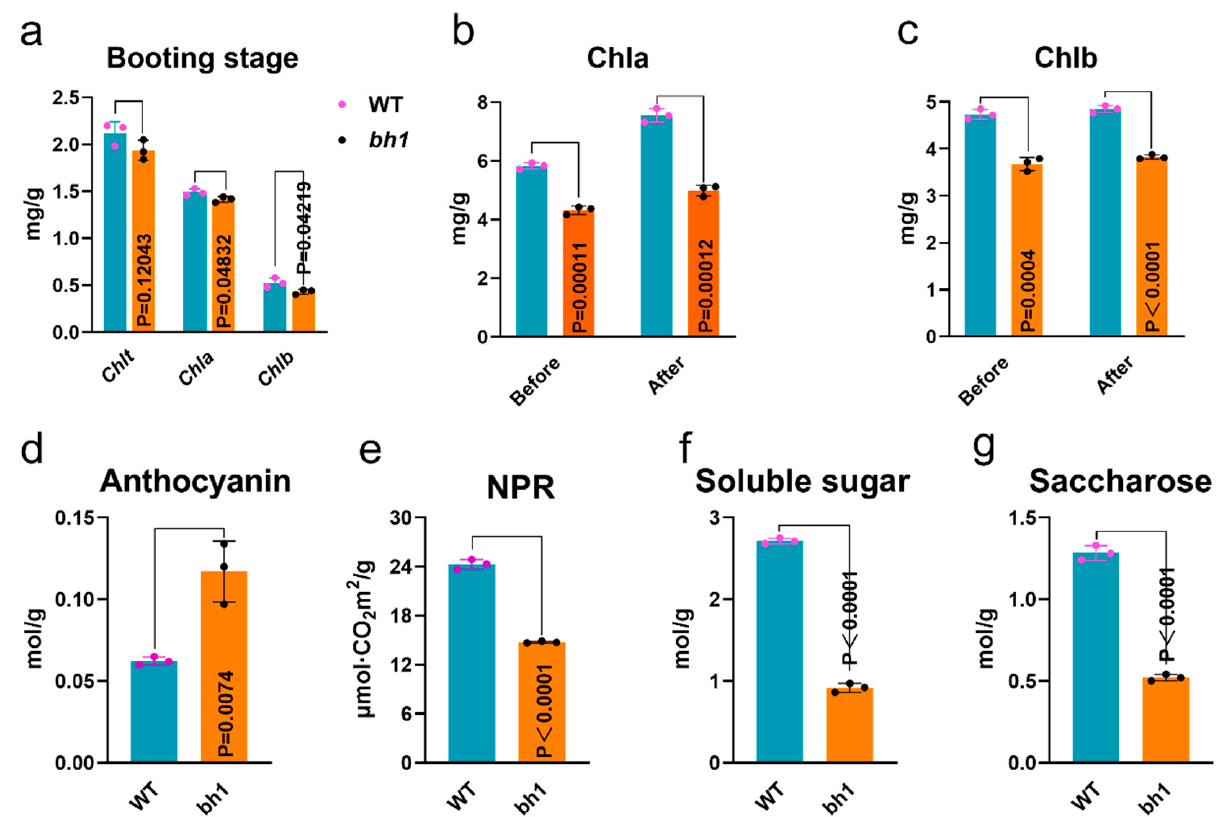
Figure 2. Comparison of photosynthetic parameters, anthocyanins and sugars contents of WT (wild type) and brown hull 1 (bh1). ( a ) Determination of photosynthetic pigment at booting stage ( b ) chlorophyll a, ( c ) chlorophyll b, ( d ) anthocyanin content in the hull, ( e ) net photosynthetic rate of mature leaves, ( f ) contents of soluble sugar ( g ) saccharose content in the hull.